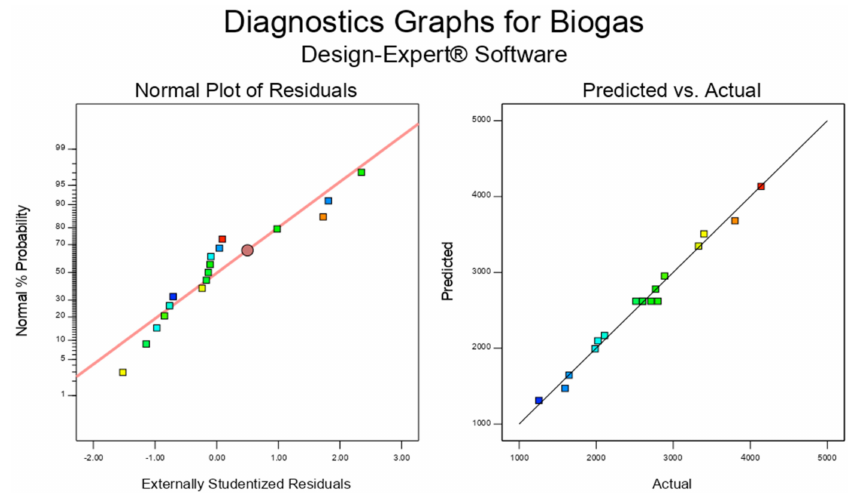
Figure 1. Normal probability and predicted versus actual residuals plot of Biogas produced from date seed.